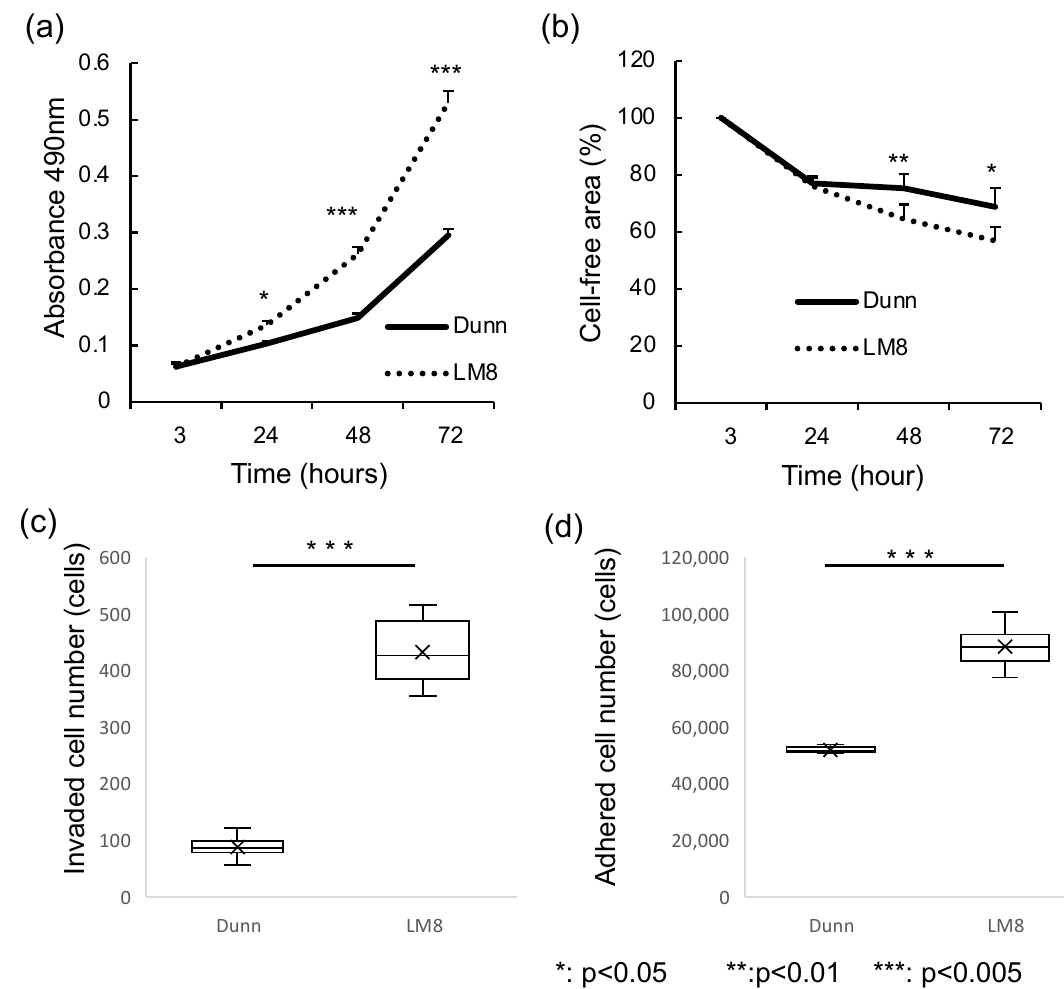
Figure 5. Functional analysis of LM8 and Dunn cells. ( a ) Cell proliferation and ( b ) migration were measured after 3, 24, 48, and 72 h in culture. ( c ) Invasion activity were calculated after 48 h treatment. ( d ) Adhesion activity was evaluated after 1 h treatment.